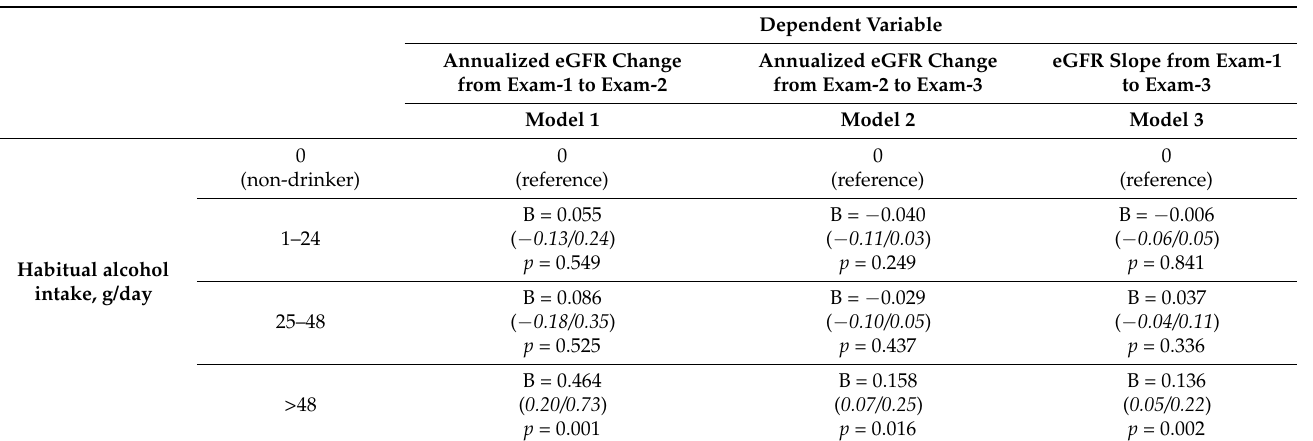
Table 4. Longitudinal analyses: multi-variable linear regression models with annualized eGFR change and eGFR slope regressed over stratum of alcohol intake and